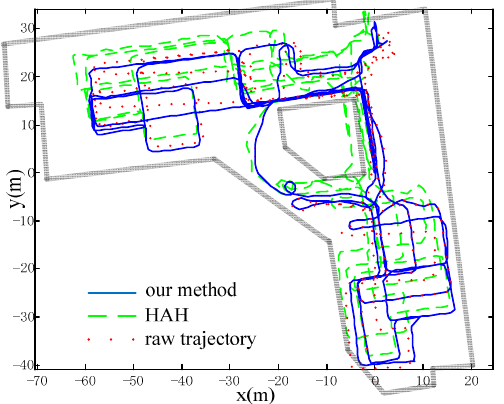
Table 2. The positioning errors for raw trajectory, HAH method and our method.